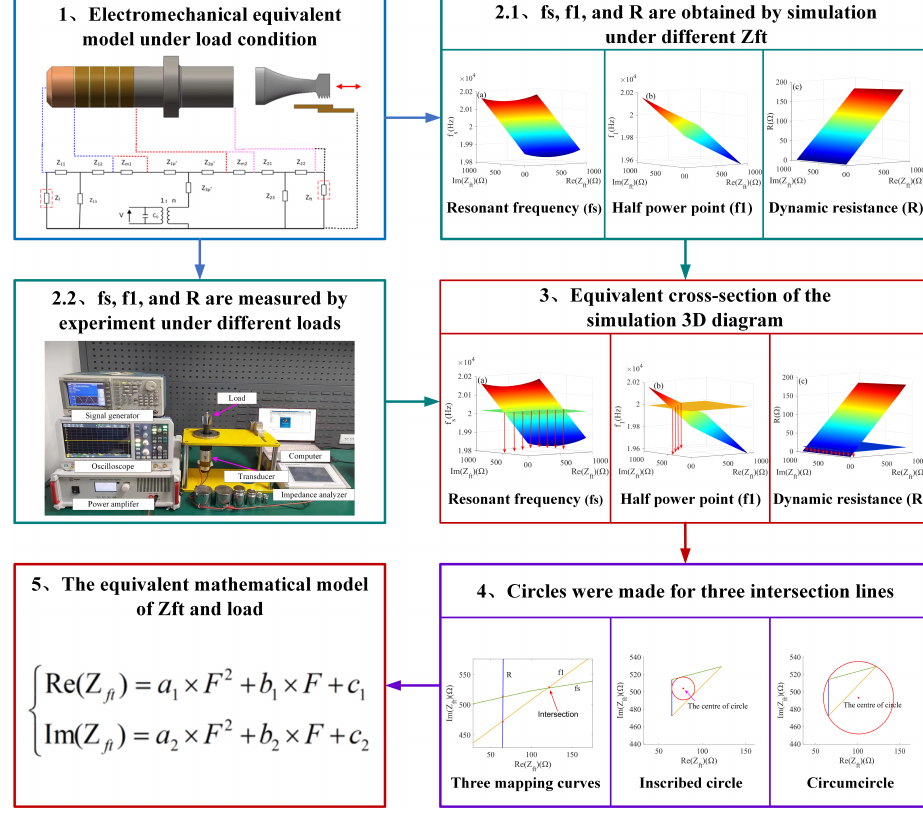
Figure 2. The main research